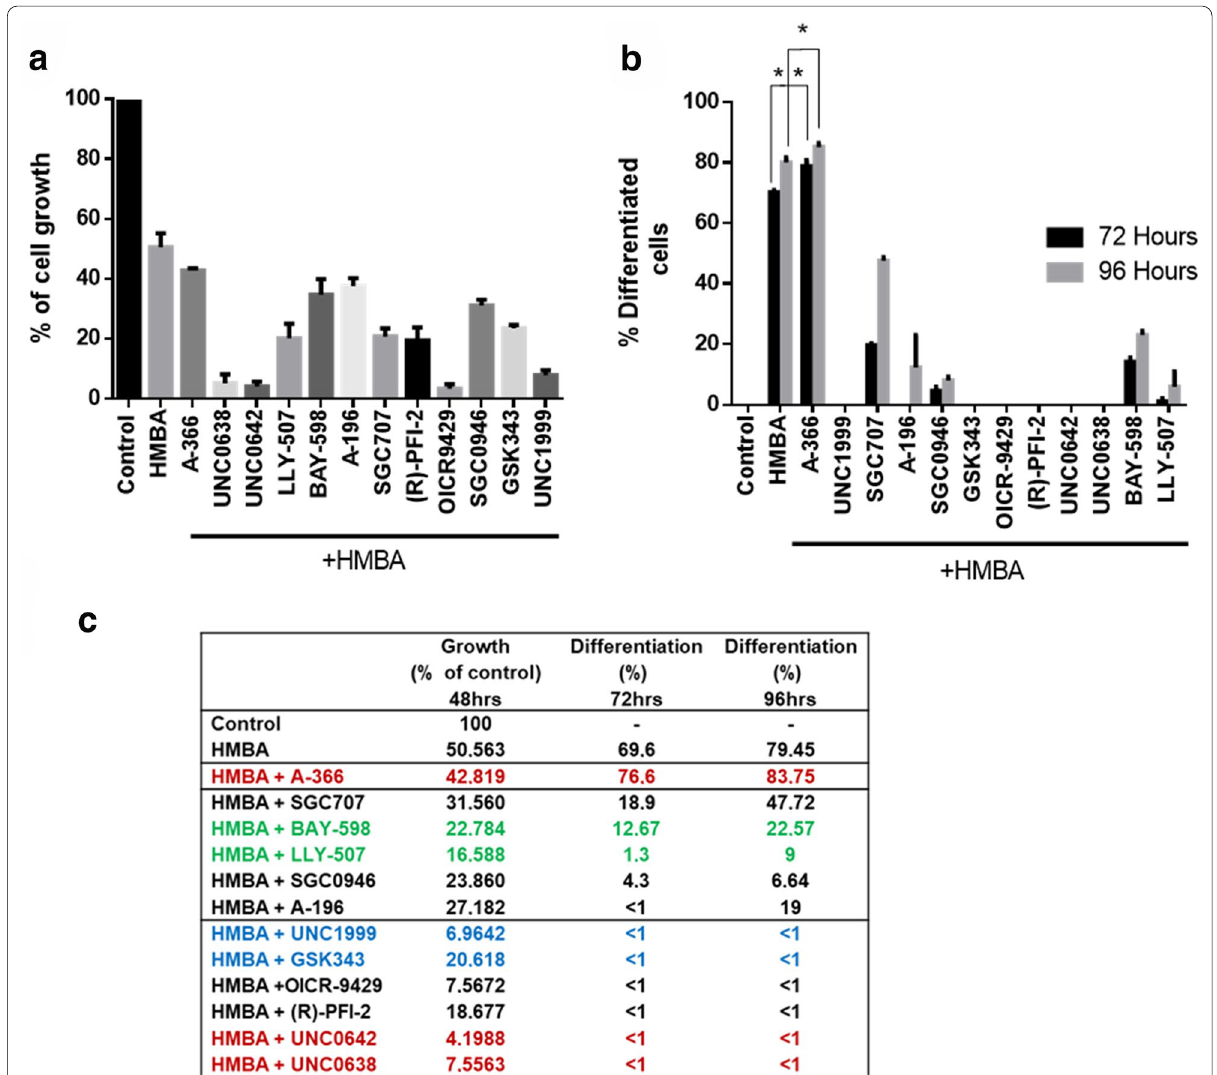
Fig. 3 Assessment of the effect of the 12 methyltransferase inhibitors on the MEL cell erythroid differentiation program. a MEL cell growth determined after 48 h of treatment with the indicated compounds. For this experiment, all probes were co-administered with the inducer of differentiation, HMBA (5 10 − 3 M; 0.5 mM) and cell growth was determined by cell counting (in a Neubauer chamber). b MEL cell differentiation × determined after 48 h and/or 72 h of treatment with the indicated compounds at a concentration equal to their IC 50 (shown in Fig. 2b). For this experiment, all epigenetic probes were co-administered with the inducer of differentiation, HMBA. Cell differentiation was determined by staining with benzidine and scoring benzidine-positive cells in culture. At least 250 cells were scored as positive or negative in each technical replication, and three technical replications were performed for each sample. ** p < 0.005; * p < 0.01; Student’s t-test. c Table summarizing the information of a and b . Each experiment was conducted in at least three biological replications. Data in all panels represent means standard ±